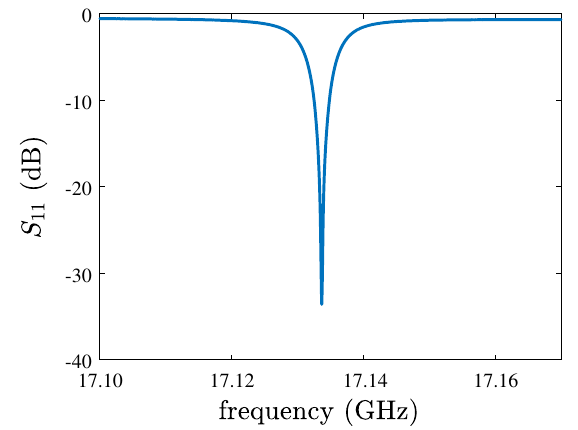
FIG. 11. Measurement result of the on-axis electric field of the E structure compared to the CST MICROWAVE STUDIO simulation